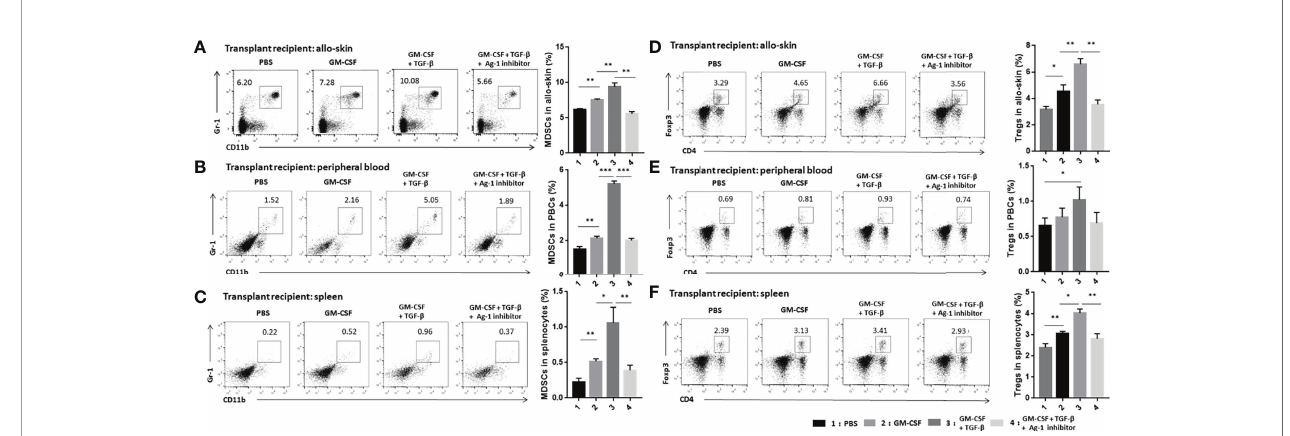
FIGURE 6 | Adoptive transfer of TGF- b + GM-CSF – induced MDSCs could signi fi cantly promote the expansion of MDSCs and Tregs in the transplant recipients. Allo-skin mice were divided into four different groups and then treated with PBS, GM-CSF – induced MDSCs, TGF- b + GM-CSF – induced MDSCs, and TGF- b + GM- CSF – induced MDSCs with Arg-1 inhibitor, respectively. Thereafter, allografts, peripheral blood, and spleen of transplant recipients were obtained on day 21 after operation for FCM assay. Typical examples of FCM analysis and proportion of CD11b + Gr-1 + MDSCs in allografts (A) , peripheral blood (B) , and spleen (C) of the transplanted mice. Typical examples of fl ow cytometry analysis and percentages of CD4 + Foxp3 + Tregs in allografts (D) , peripheral blood (E) , and spleen (F) of the transplant mice. The data have been shown as mean ± SEM (n = 3) and were analyzed by one-way ANOVA analysis. * P < 0.05, ** P < 0.01, and *** P < 0.001 compared between the different